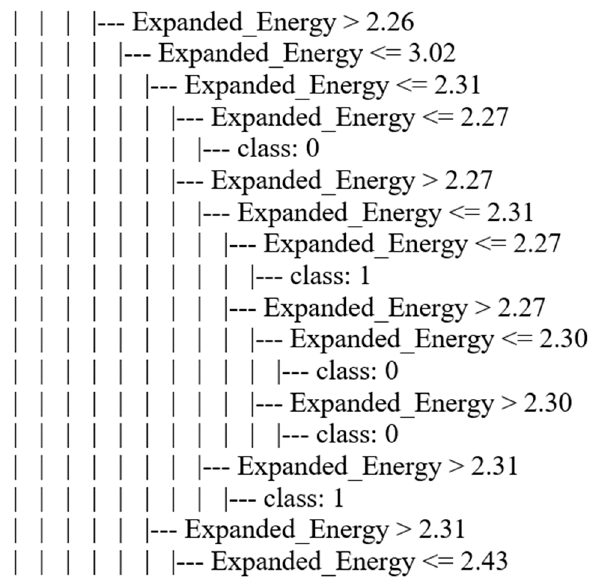
Figure 5. A sample of the WC+DT output model for the WSN-DS dataset.